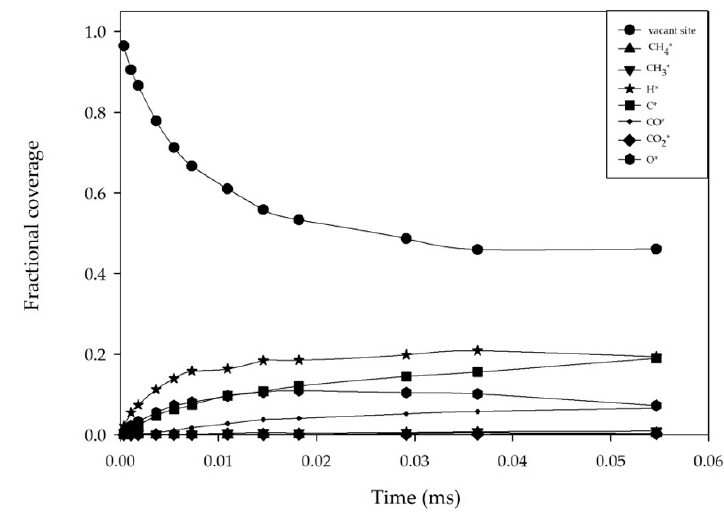
= (cid:3120) = 0.5. = 4 (cid:3120)